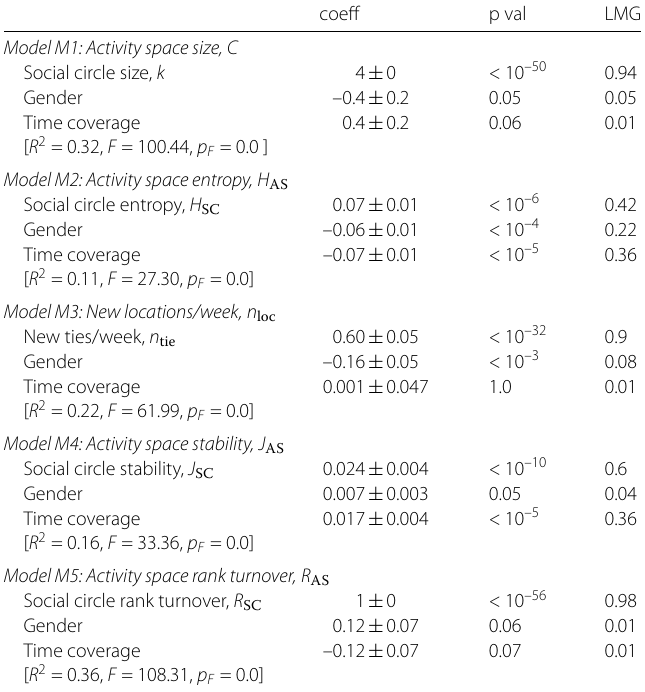
Table 5 Linear regression models for the CNS dataset. For each model, we show the coefficients (coeff) calculated by the regression model, the probability (p val) that the variable is not relevant, and the relative importance (LMG) of each regressor computed using the Lindeman, Merenda and Gold method [79]. Gender is a binary variable taking value 1 for females and 2 for males. For this dataset, age is not relevant as all participants have similar age. For each model, we report the R 2 goodness of fit, the F -test statistics with the corresponding p -value p F coeff p val LMG ModelM1:Activityspacesize, C Social circle size,